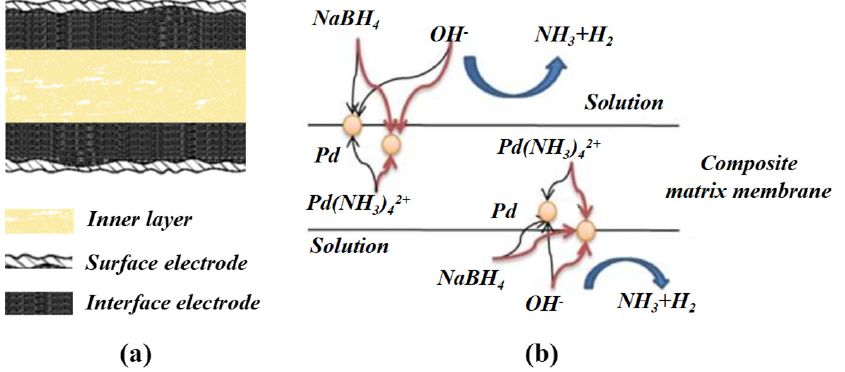
Figure 1. ( a ) Schematic illustration of SCNT/Pd − electrode IPMC; ( b ) formation mechanism of SCNT/Pd composite interface electrode.